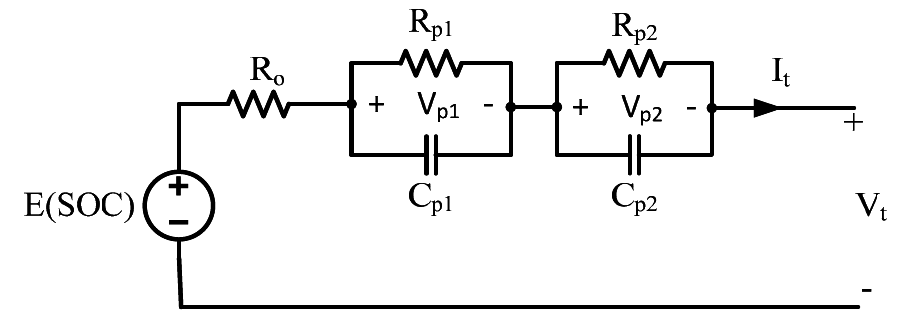
Figure 1. Equivalent circuit of Li-ion battery.